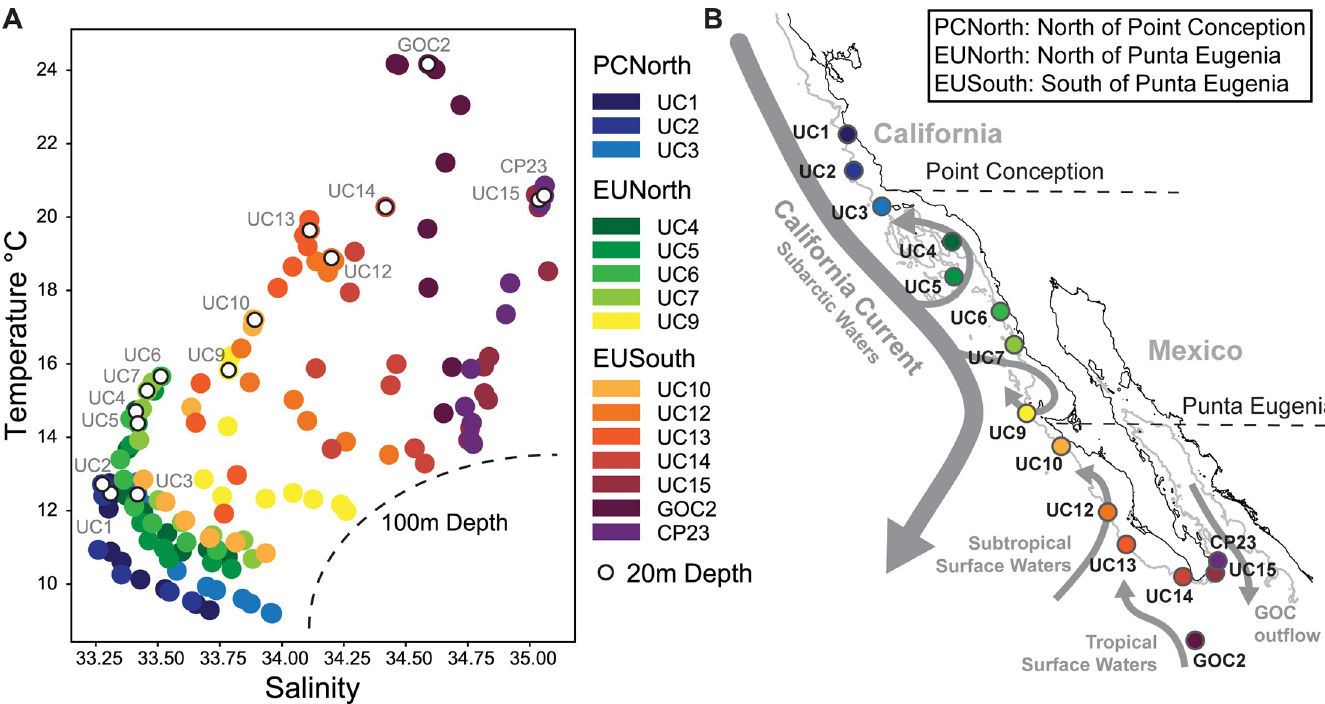
Fig 1. Environmental variability and sampling locations along cruise track. (A) Temperature versus salinity at each station at depths 0-100m showing 10m increments. Values at 20m are highlighted. (B) Location of each sampling station alongside 1000m bathymetric contour and an overview of the dominant water masses in the region. The California Current is shown as it runs offshore of the western coast of North America before diverging at Punta Eugenia and eventually feeding into the North Equatorial Current as part of the North Pacific Subtropical Gyre